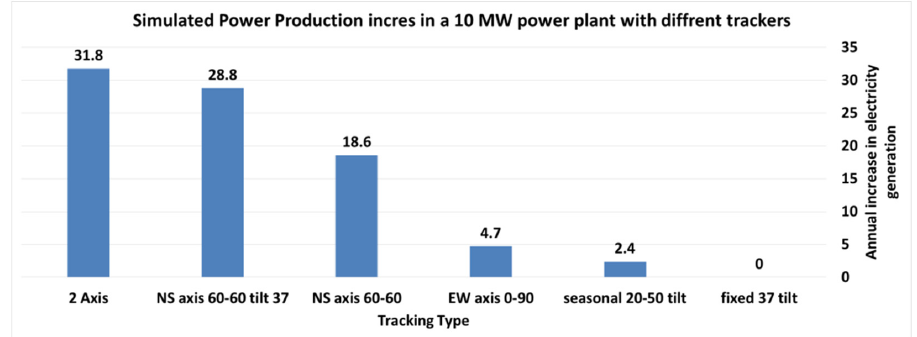
Figure 15. Increasing energy production in the installation mode of different trackers compared to the fixed mode.